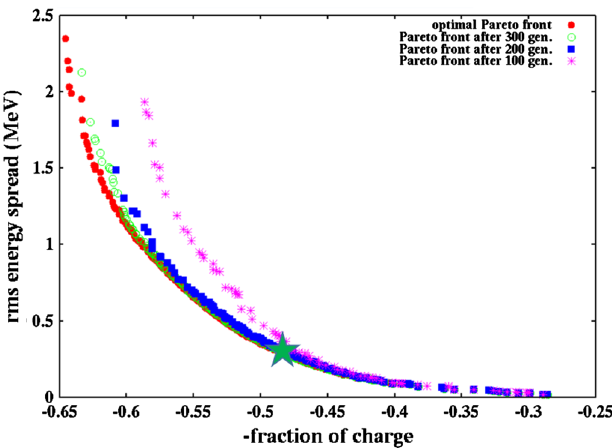
FIG. 6. The Pareto front after 100 generations (magenta), after 200 generations (blue), after 300 generations (green) and the final optimal Pareto front (red) of longitudinal phase space